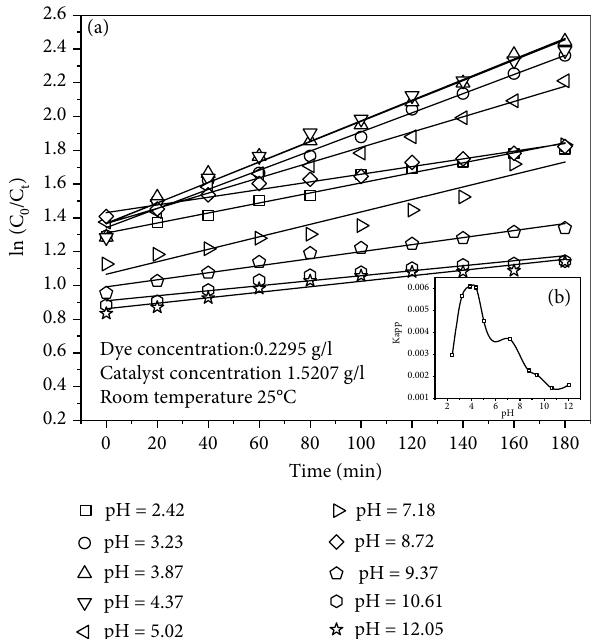
Figure 2: Regression curves and the corresponding results for degradation of W-7G at various pH values. (a) Kinetic regression curves. (b) Apparent reaction rate coe ffi cients curve of photocatalytic